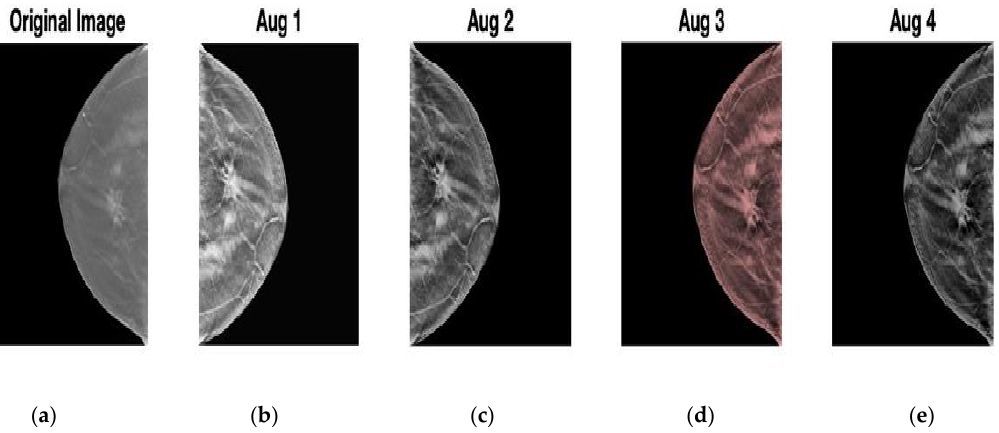
Figure 2. Samples of different applied augmentation techniques ( a ) original image, ( b ) output of Aug1, ( c ) output of Aug2, ( d ) output of Aug3, ( e ) output of Aug4. Aug1, ( c ) output of Aug2, ( d ) output of Aug3, ( e ) output of